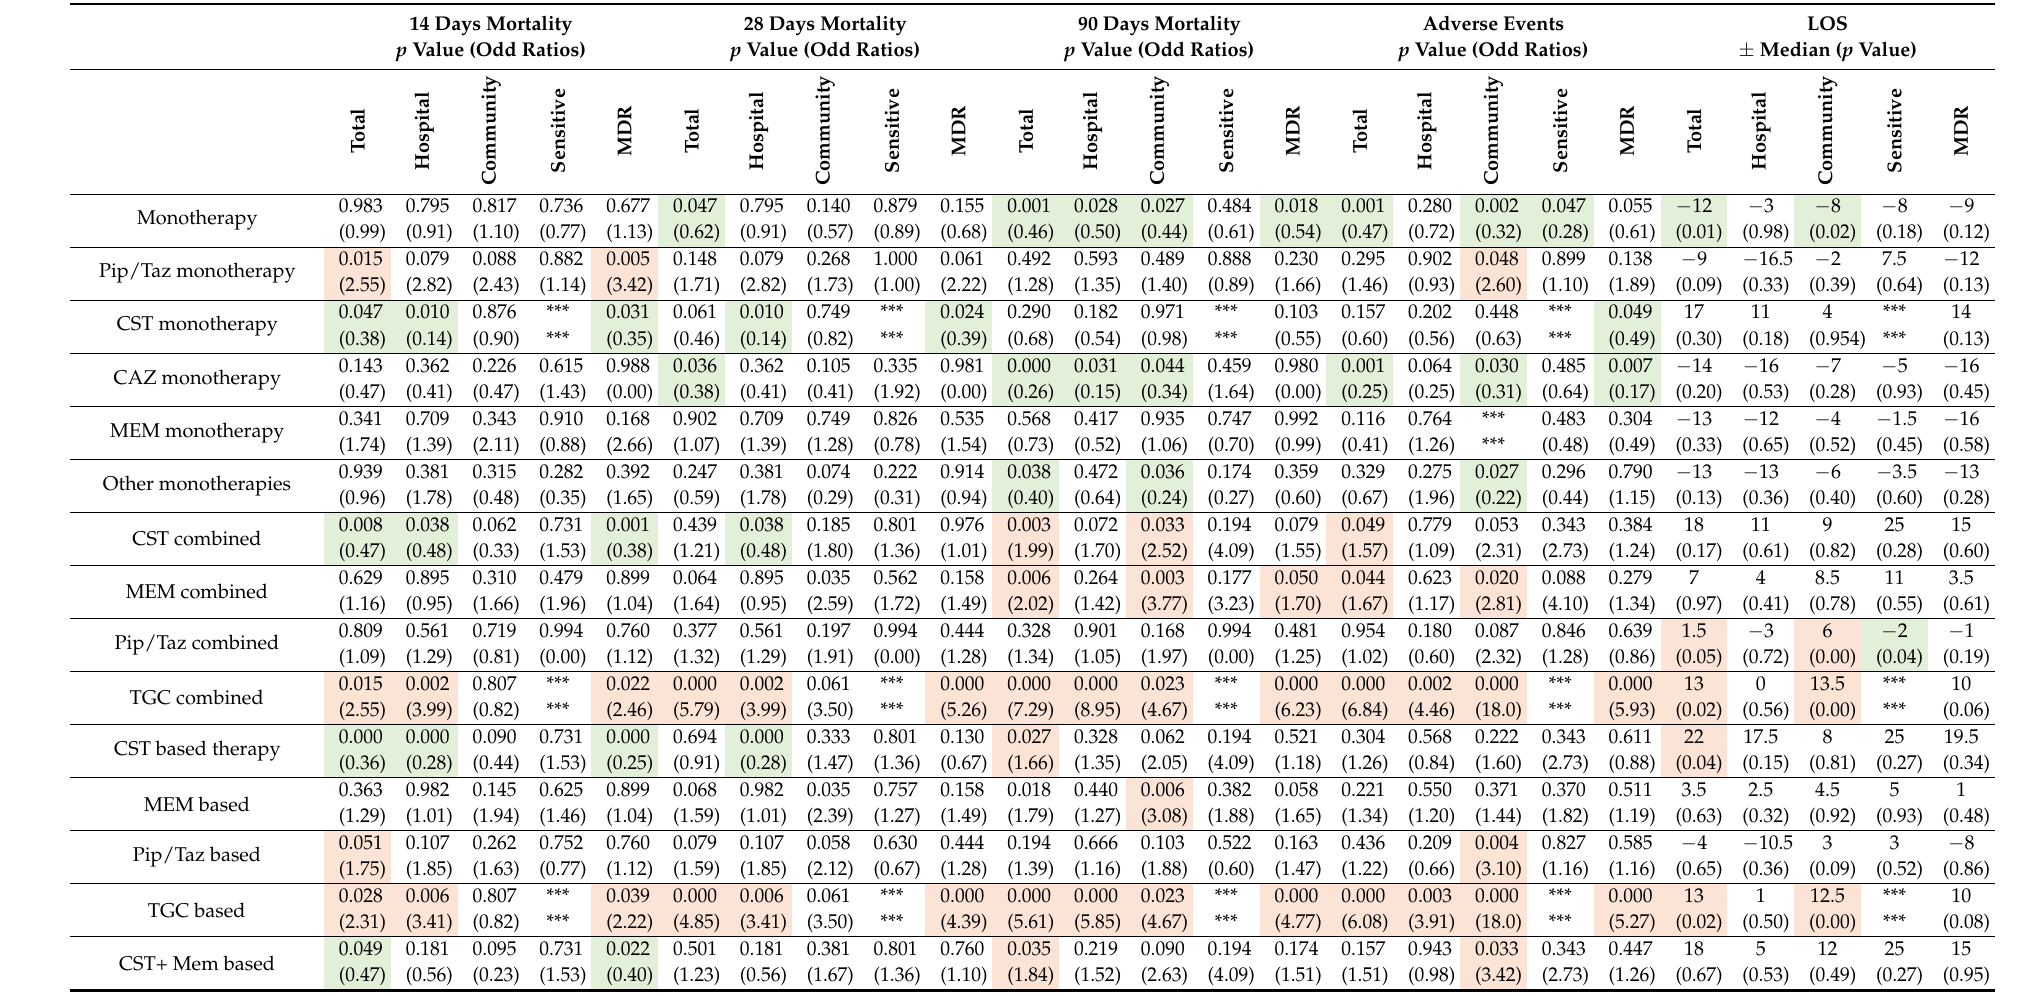
Table 3. Treatment outcomes for A. baumannii